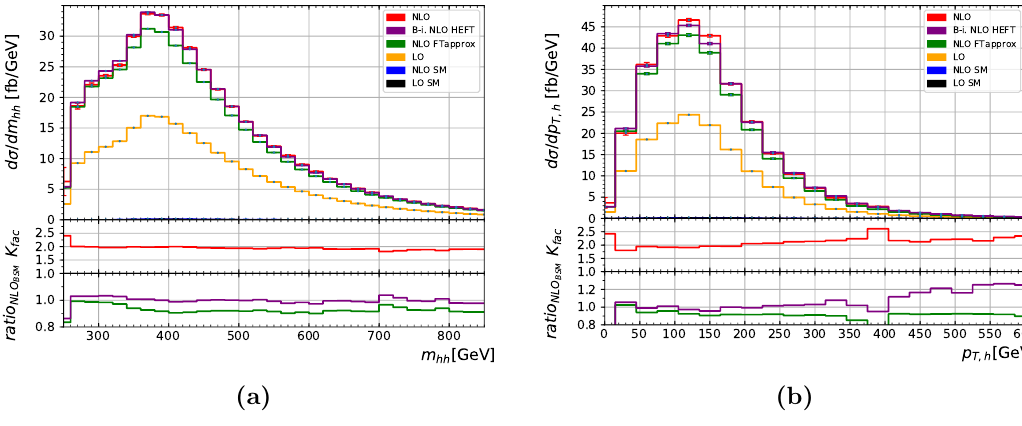
Figure 15. Same as (cid:12)gure 12 but for benchmark point 4, c hhh = (cid:0) 3 : 5 ; c t = 1 : 5 ; c tt = (cid:0) 3 ; c ggh = c gghh =